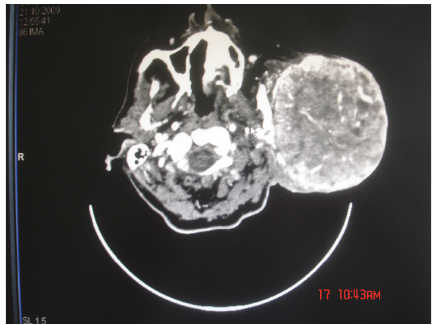
Figure 1: Postcontrast CT scan of the tumor.